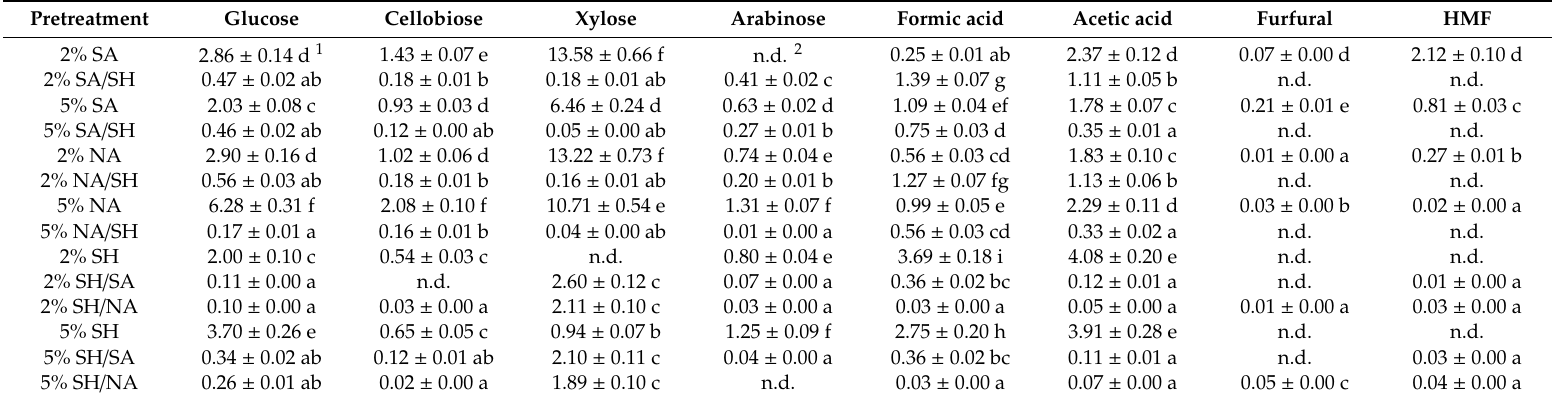
Table 2. Concentration of sugars, organic acids and furan compounds (g / L) in liquids after single and two-stage pretreatment of JAS. Pretreatment